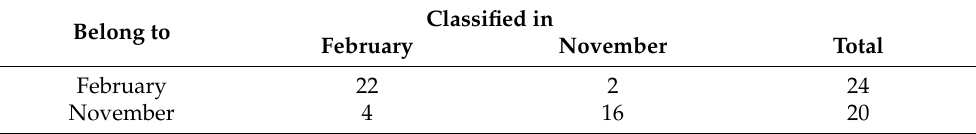
Figure 3. Rostral morphological patterns of Hippolyte sapphica morphotypes. ( A ) to the total number of morph-A individuals (pool), and after removal of allometry ( B ) morph-A females in mixed population, ( C ) morph-A males in mixed population, ( D ) morph-A females in unmixed population, ( E ) morph-A males in unmixed population, ( F ) morph-A males in mixed population, seasonal (typical point shifts for November), ( G ) morph-B 1st cluster, ( H ) morph-B 2nd cluster, NI: number of individuals. Table 2. Seasonal classification table of Hippolyte sapphica morph-A species, according to discriminant analysis.